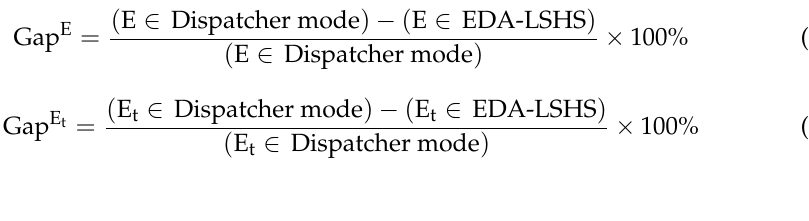
Table 4. The max gap, average gap, and min gap of four gaps.